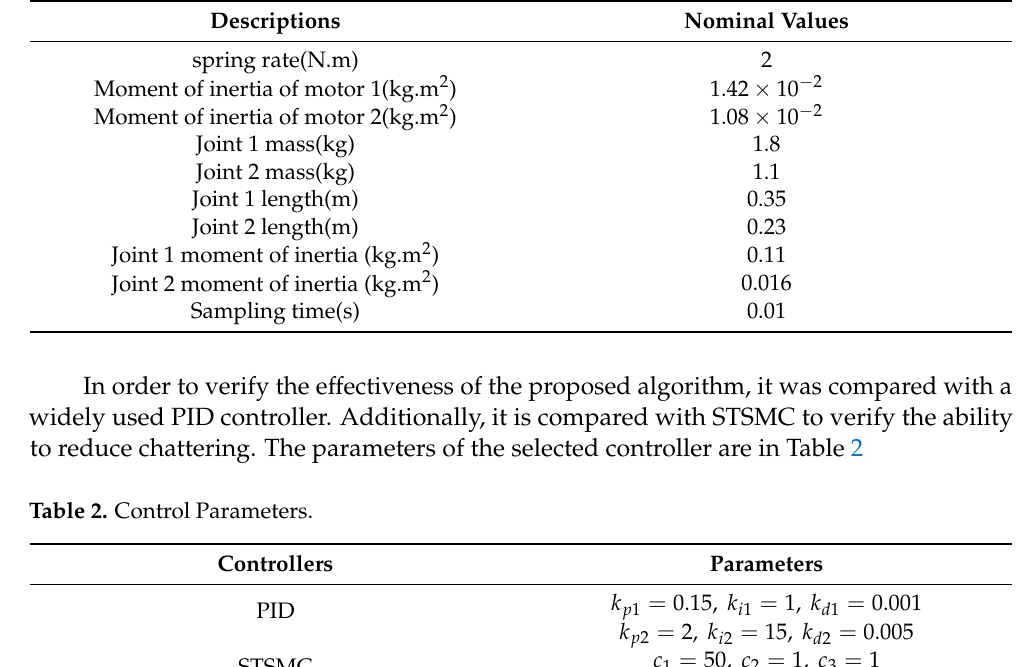
Table 1. Parameters of two-degree-of-freedom flexible upper limb exoskeleton.